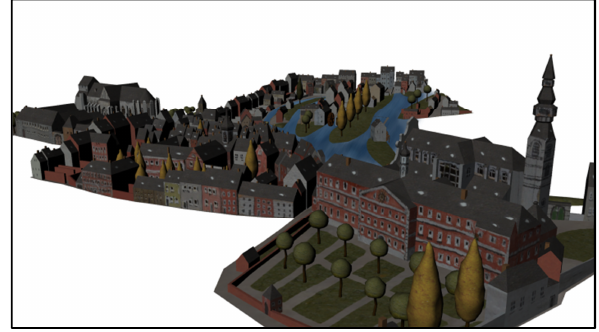
Figure 2. Snapshot of the 3D reconstruction in Maya. This subset of the 3D model shows the textured building modelled from the 3D point cloud.